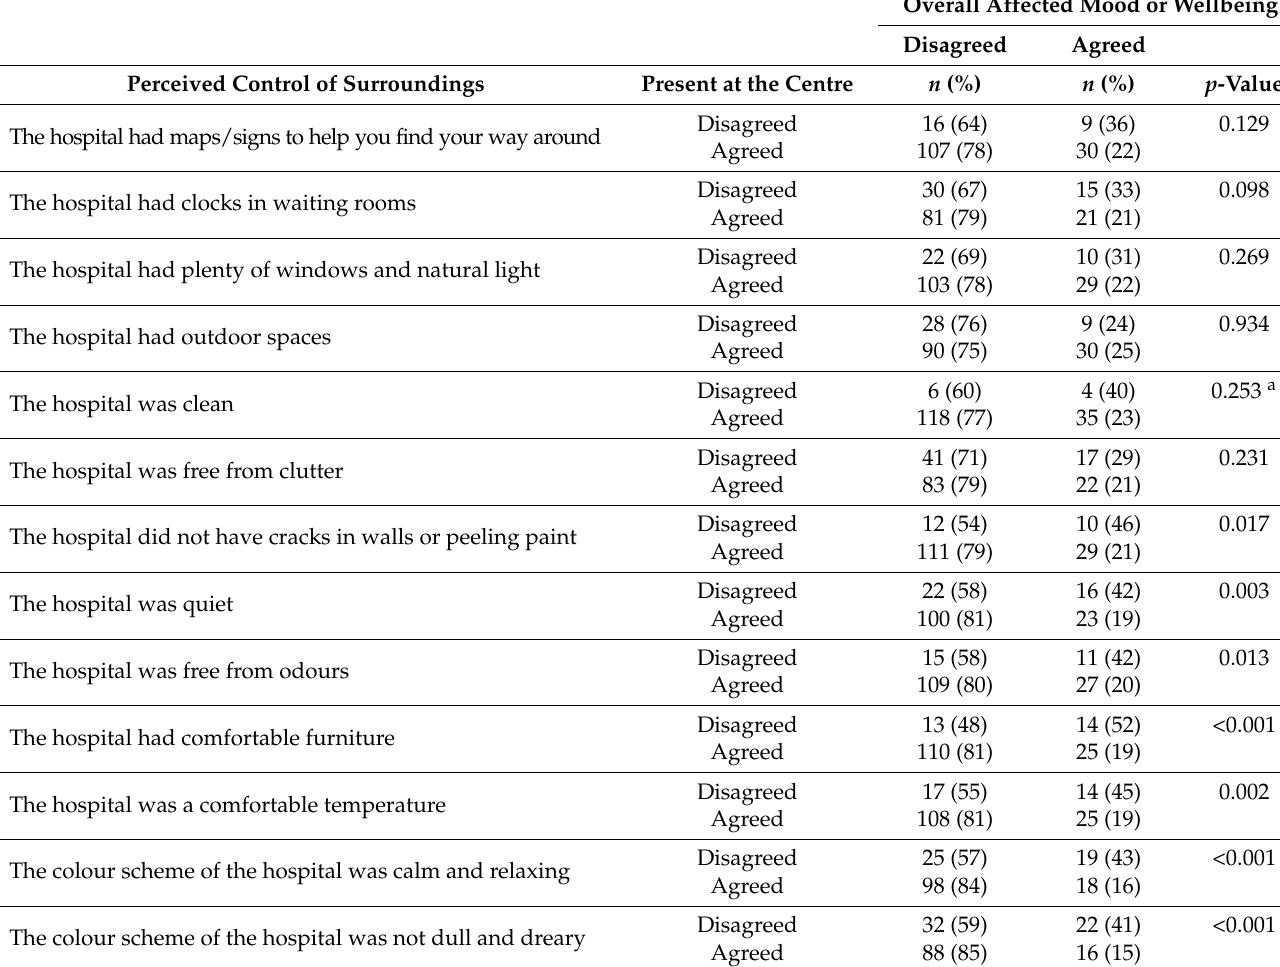
Table 2. Patient perceptions of hospital elements related to the Perceived Control of Surroundings and univariate associations with self-reported mood or well-being related to the overall treatment environment ( n = 165).